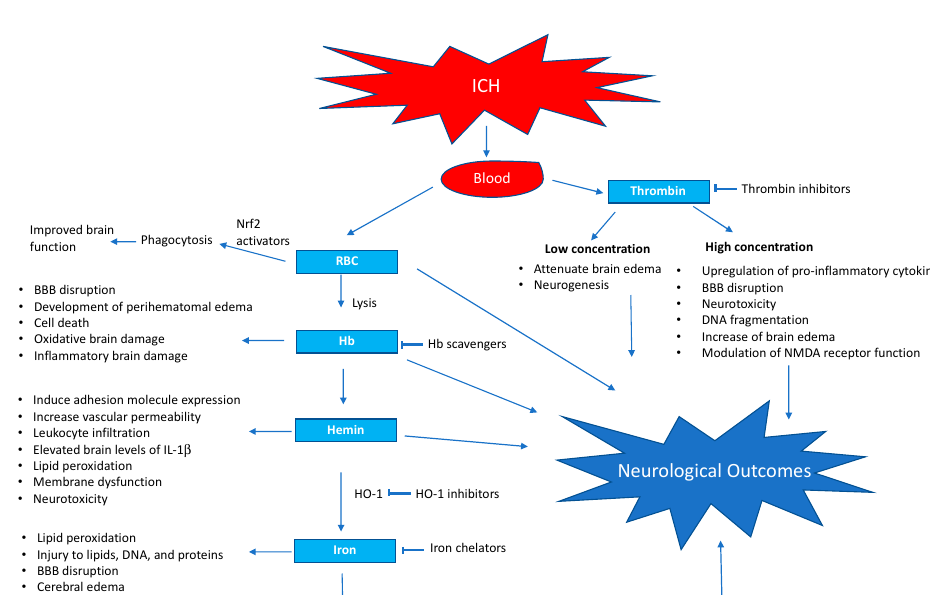
Figure 1. Schematic representation of blood-induced neurotoxicity after intra cerebral hemorrhage and selected points of action of pharmacological interventions. BBB, blood–brain barrier; NMDA, N- methyl-D-aspartate.